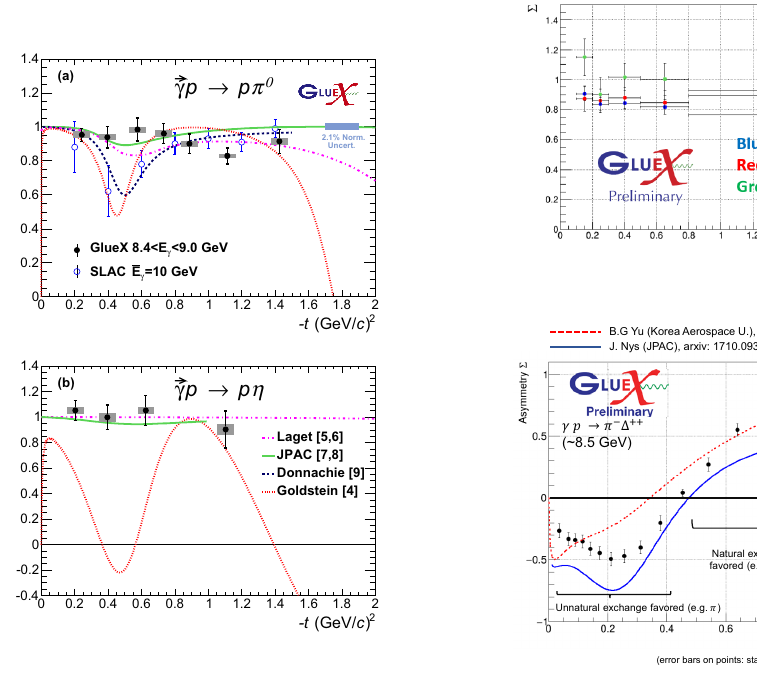
Figure 3: (Left) The beam asymmetry measurements of π 0 along with prior measurements and theory curves (a) and η with theory curves (b). (Right-Top) The preliminary results of the updated analysis of the η beam asymmetry using roughly five times the statistics [7]. (Right- Bottom) The preliminary results of the beam asymmetry of π − from the reaction γ p → π − Δ ++